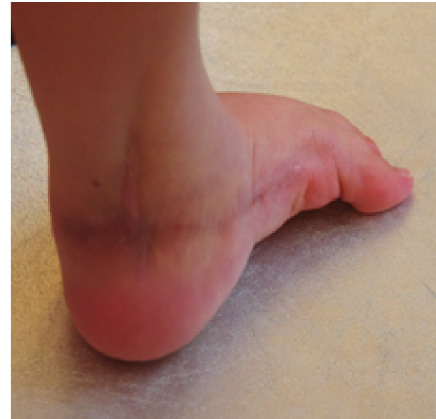
Figure 3: Clubfoot status after revision surgery with recurrent deformity, posterior view.